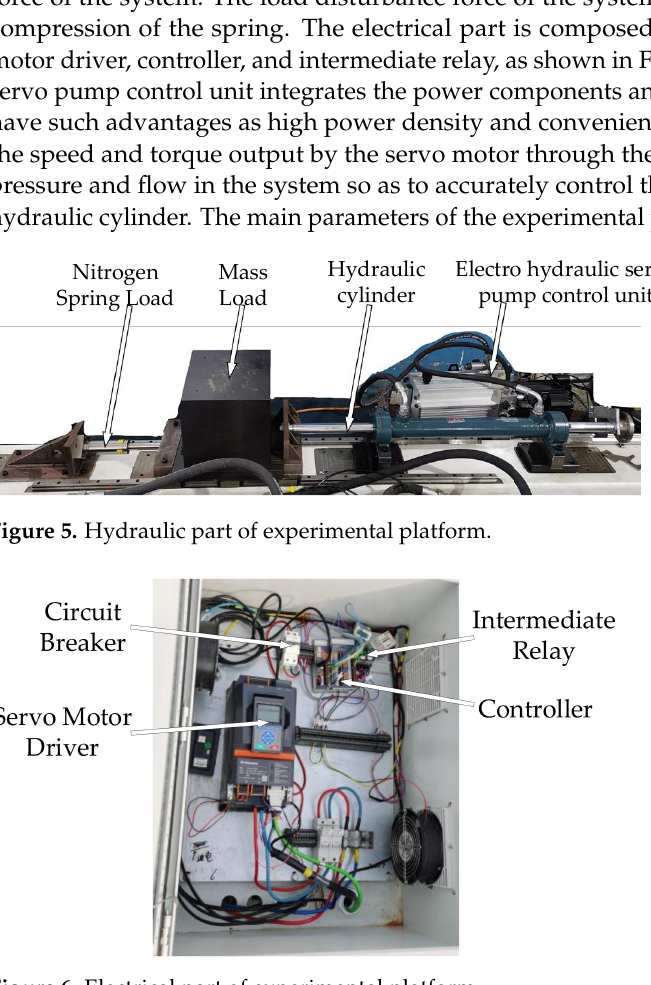
Figure 6. Electrical part of experimental platform. Table 2. Main parameters of the experimental